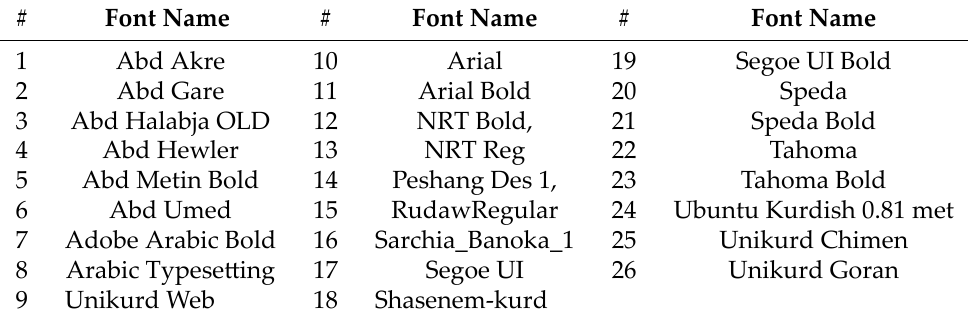
Table 7. Fonts used by Shreeshrii to fine‑tune the Arabic language model for